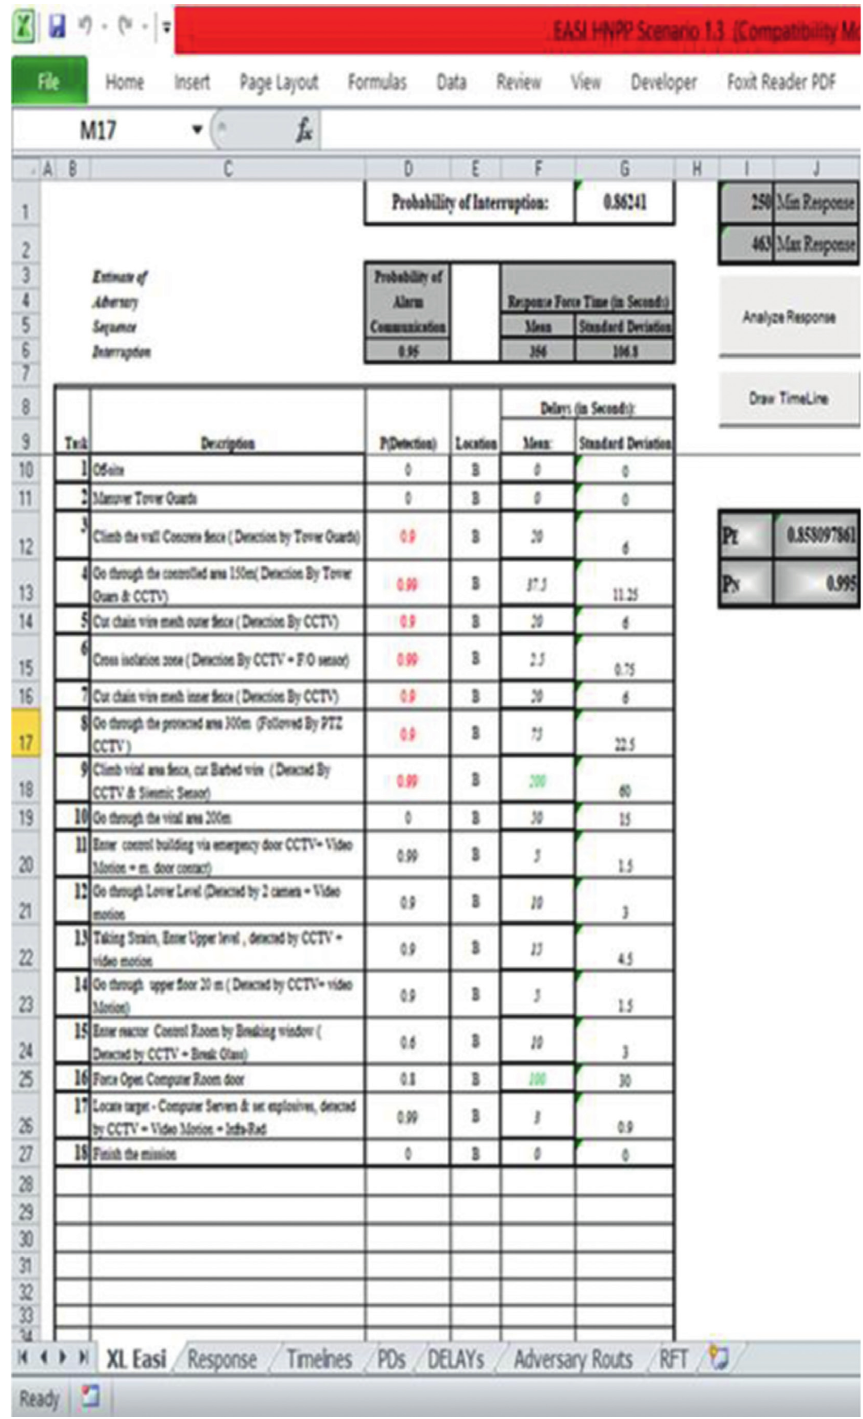
Figure 9: Attack path action sequence and EASI calculations of P